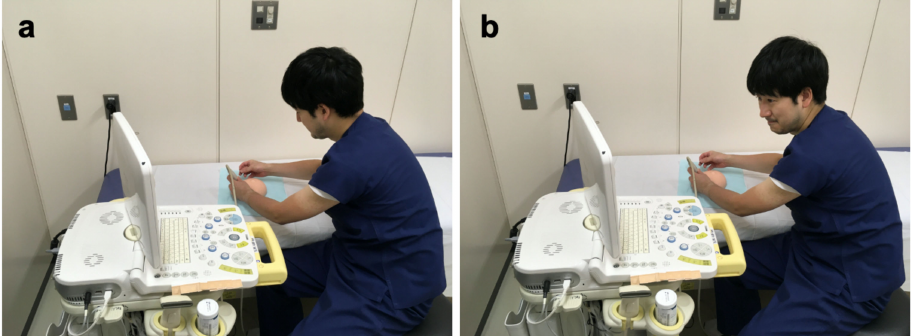
Figure 1. ( a , b ) Photographs during US-guided procedure with the standard US display